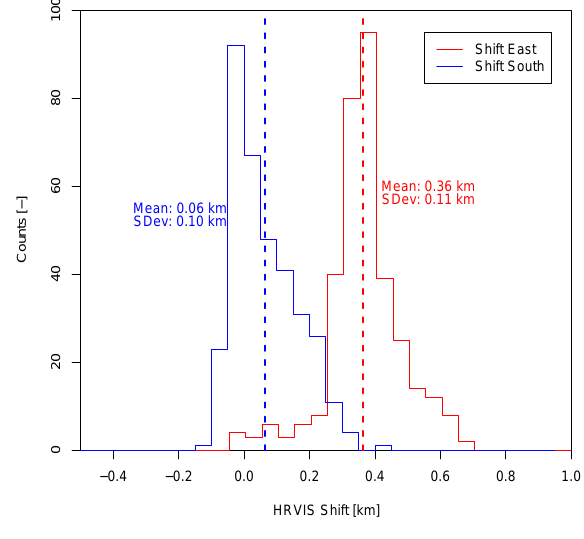
Fig. 6. Histogram of the shifts of the HRV image relative to the 0.6 and 0.8µm channel in Northern and Eastern direction, obtained for 345 Meteosat-9 scenes from 2008. The shift of the images is expressed as distance at the nadir point of the satellite in kilometers